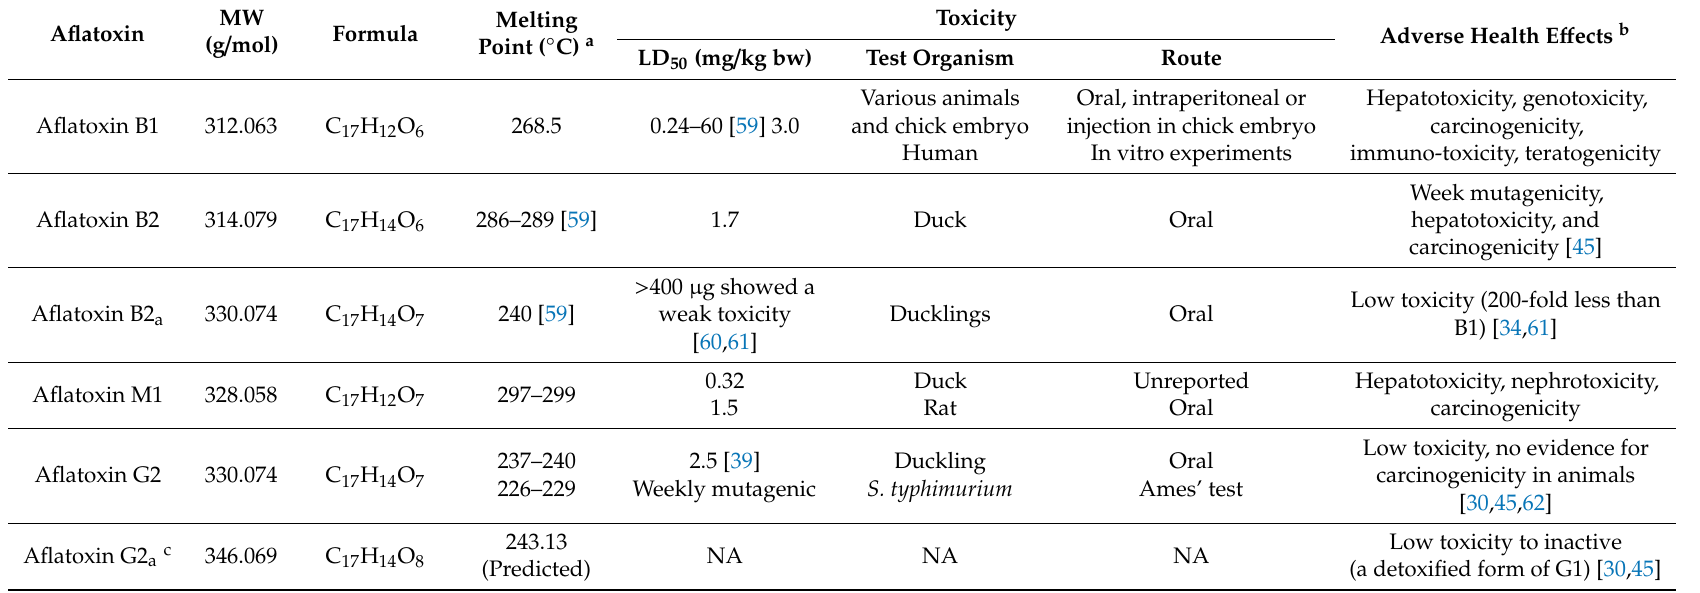
Table 2. Key properties of aflatoxins and their metabolites. Data compiled from PubChem of the National Center for Biotechnology Information [57]) and ChemSpider of the Royal Society of Chemistry [58] databases, unless references are indicated beside the